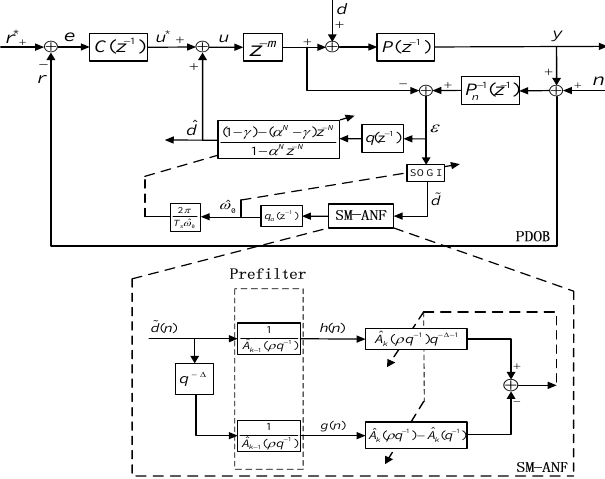
Figure 12. Block diagram of adaptive PDOB based on the Stieglitz–McBride (SM) method.